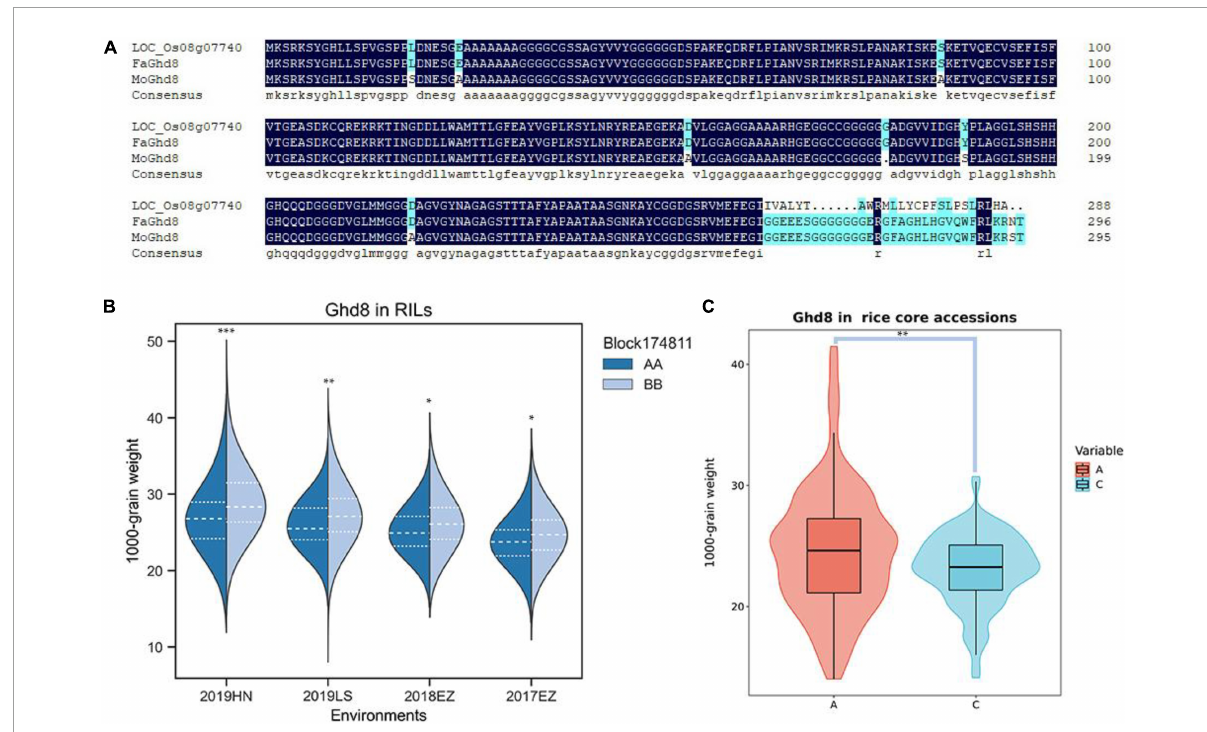
FIGURE5 The candidate gene prediction of qKGW-8.1 . (A) . Protein sequence alignment results of Nipponbare, RPYgeng ( FaGhd8 ), Luohui 9 ( MoGhd8 ). (B) The 1,000-grain weight of RPY geng (AA) and Luohui 9 (BB) allele recombinant inbred lines (RILs). (C) The 1,000-grain weight of different allele rice core accessions.